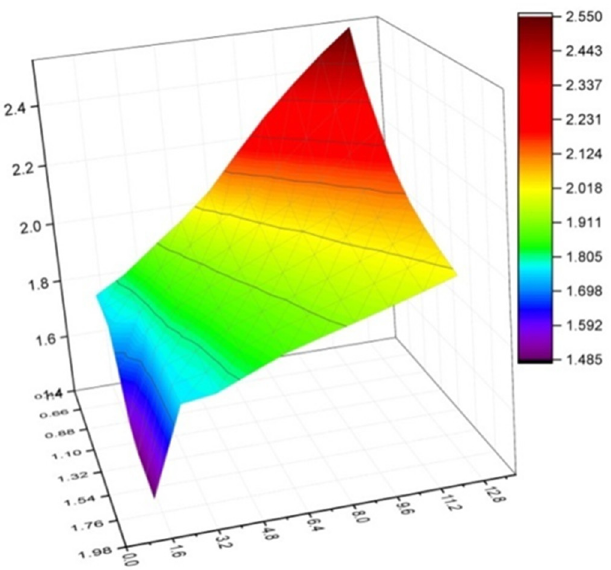
Figure 19. Dependence of the stress concentration factor on the geometric field joint imperfection dimensions ς , ξ .